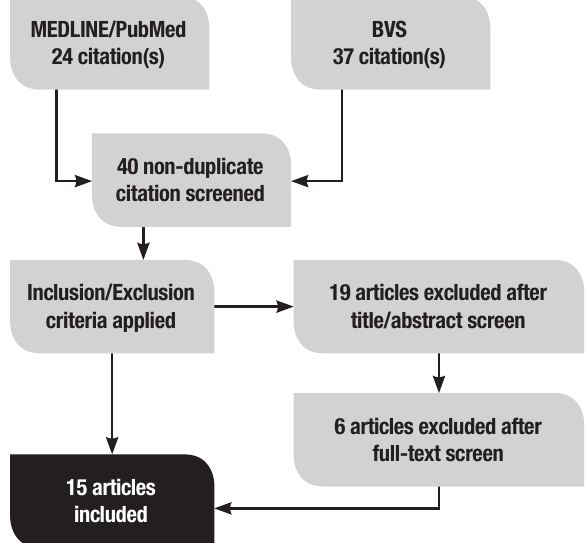
Figure 1. Selection of the studies evaluated.